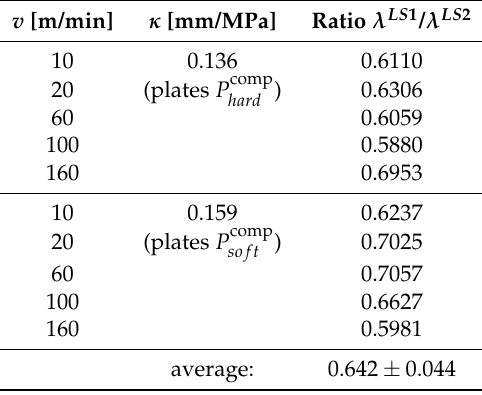
Table 3. The ratios of the observed dominant pattern wavelengths in samples printed with the inks LS1 and LS2 of viscosities η ( LS 1 ) = 200 ± 100 mPas and η ( LS 2 ) = 19 mPas, respectively, but identical surface tensions σ = 38 ± 1 mN/m, using printing plates with the same velocities v and gap widening coefficients κ . v [m/min]